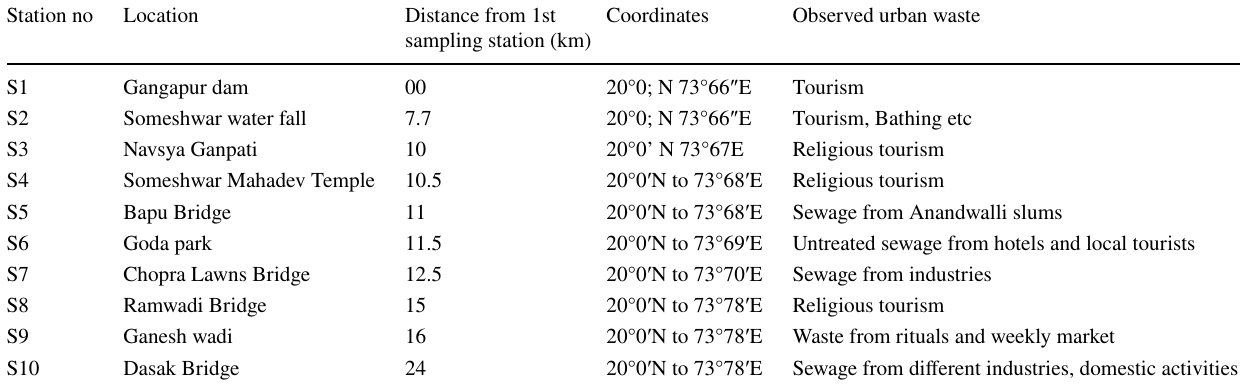
Table 7 Godavari river water sampling stations and observed urban waste